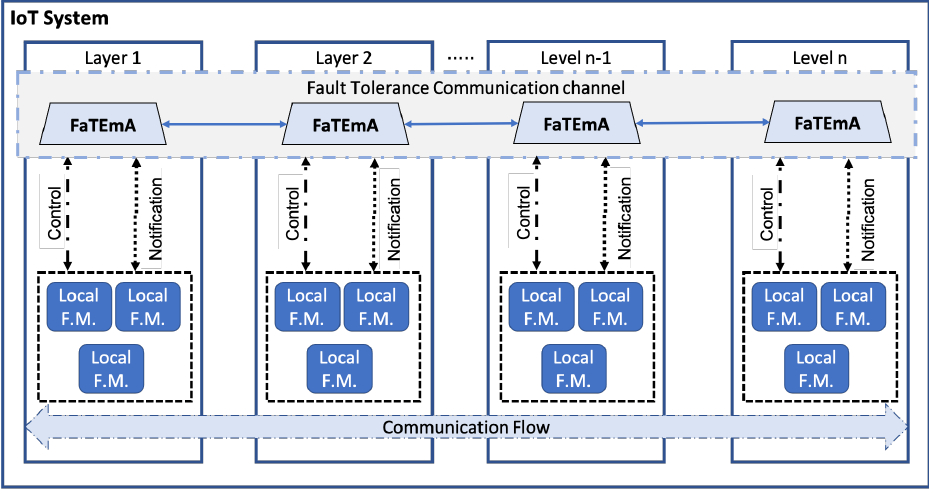
Figure 2. The multi-layer fault tolerance approach using